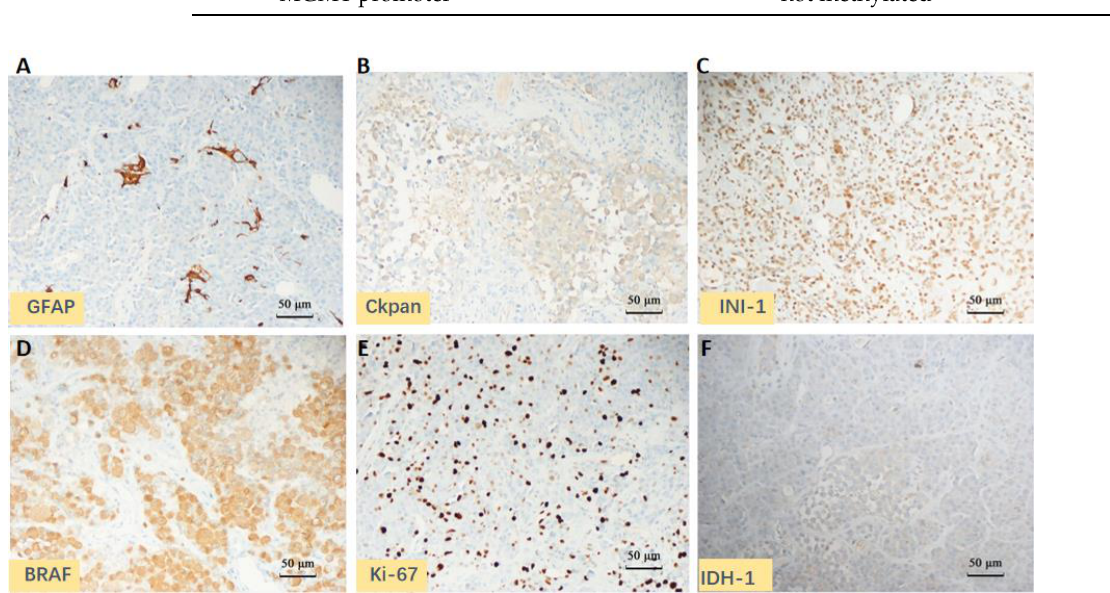
Figure 3. Immunohistochemical findings: ( A ) Immunohistochemical studies showed GFAP partial positive, and ( B ) Cytokeratin Pan (Ckpan) was partially positive. ( C ) Integrase interactor 1 (INI1) staining was universally intact. ( D ) Positive expression of BRAF V600E in EGBM. ( E ) Ki-67 was 40% positive. ( F ) IDH1 was negative.